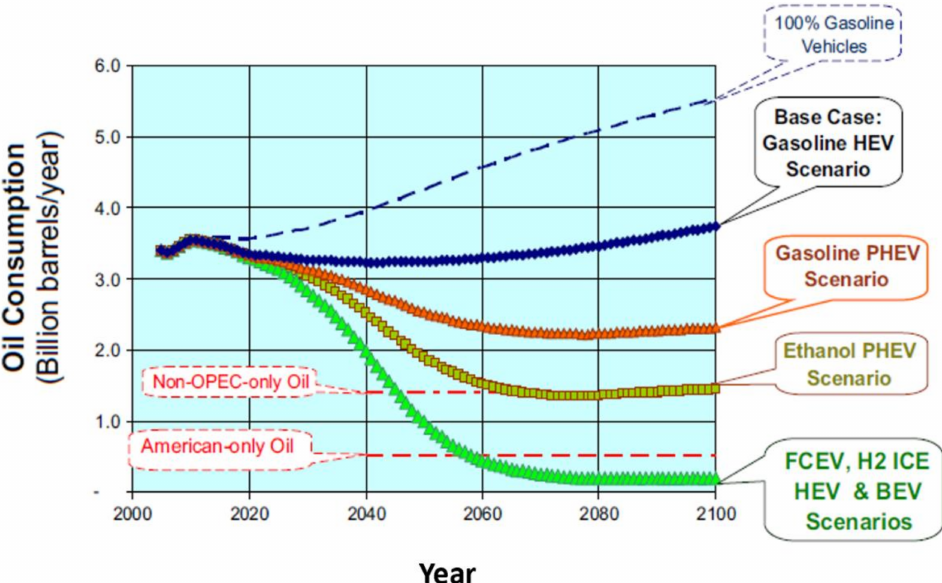
Figure 3. Oil consumption from US light-duty vehicles over the 21st century for different alternative vehicle scenarios